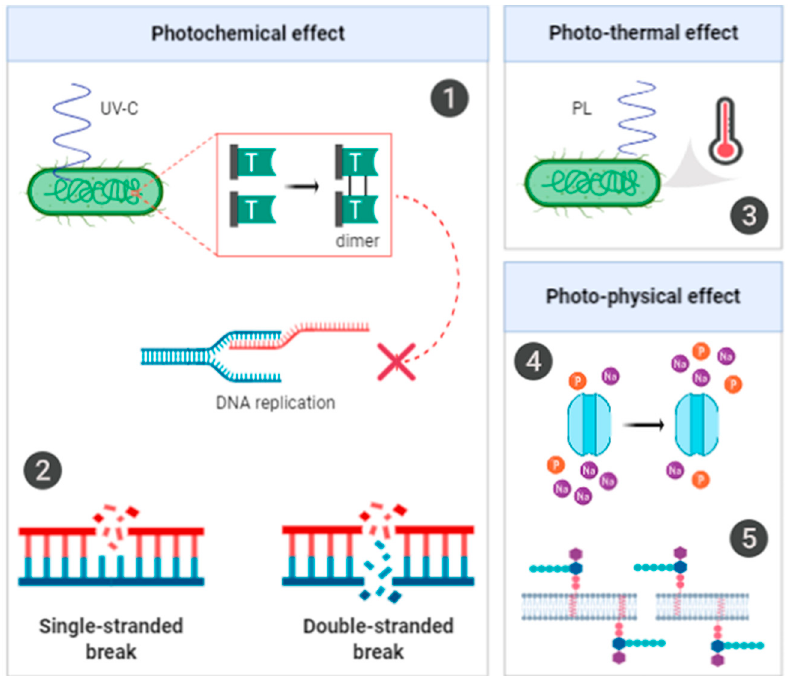
Figure 2. Photochemical, photo-thermal and photo-physical effects of UV-C radiation on microorganisms. ( 1 ) formation of dimers from adjacent thymines and inhibition of DNA replication, ( 2 ) single- and double-stranded breaks of DNA chains, ( 3 ) locally increased temperature, ( 4 ) ion flow modification and ( 5 ) membrane permeation.